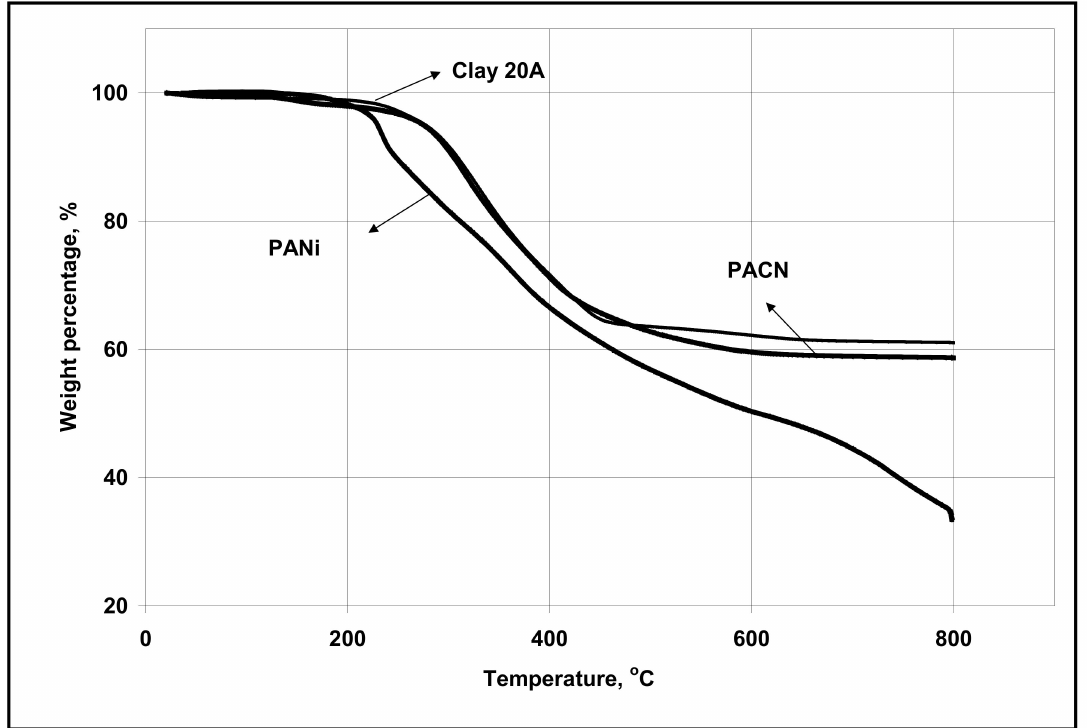
Figure 15. TGA traces for PANi, PACN, and CLOISITE ® Clay 20 A. It was found, from DSC study, that the PANi formed possessed crystalline structure, and a cold crystallization temperature and melting point typical of semicrystalline polymers are clearly shown in the DSC thermograms (see Figure 17). A decrease in the melting point was observed as the oxidant concentration increased, possibly due to increased restriction on PANi chain folding and close packing due to increased stiffness of the quinoid group (Figure 18). This assertion is supported by both FTIR and TGA results. A comparison of the DSC thermograms of PANi and PACN is shown in Figure 19. The melting point of PACN obtained at 0.5 wt% oxidant concentration was shown to be about 30 ◦ C higher than that for the neat